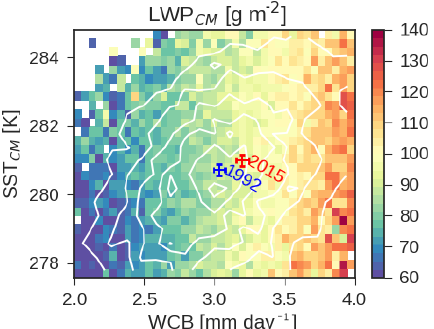
Figure 5. Average Southern Ocean cyclone LWP CM binned as a function of SST CM and WCB moisture flux for the latitude band 44.5 to 59.5 ◦ S, following Manaster et al. (2017). Contours of cy- clone distribution are shown in white. The mean cyclone WCB moisture flux and SST CM for 1992 and 2015 are shown as blue and red points, respectively. Error bars show the 95% confidence on the